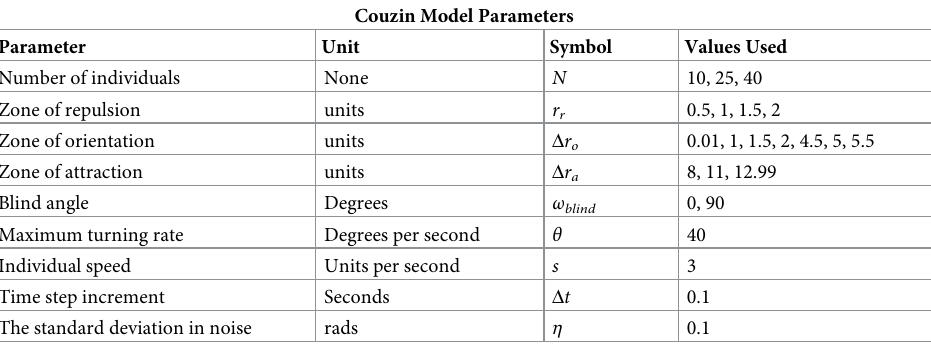
Table 1. Summary of parameters used in zonal model